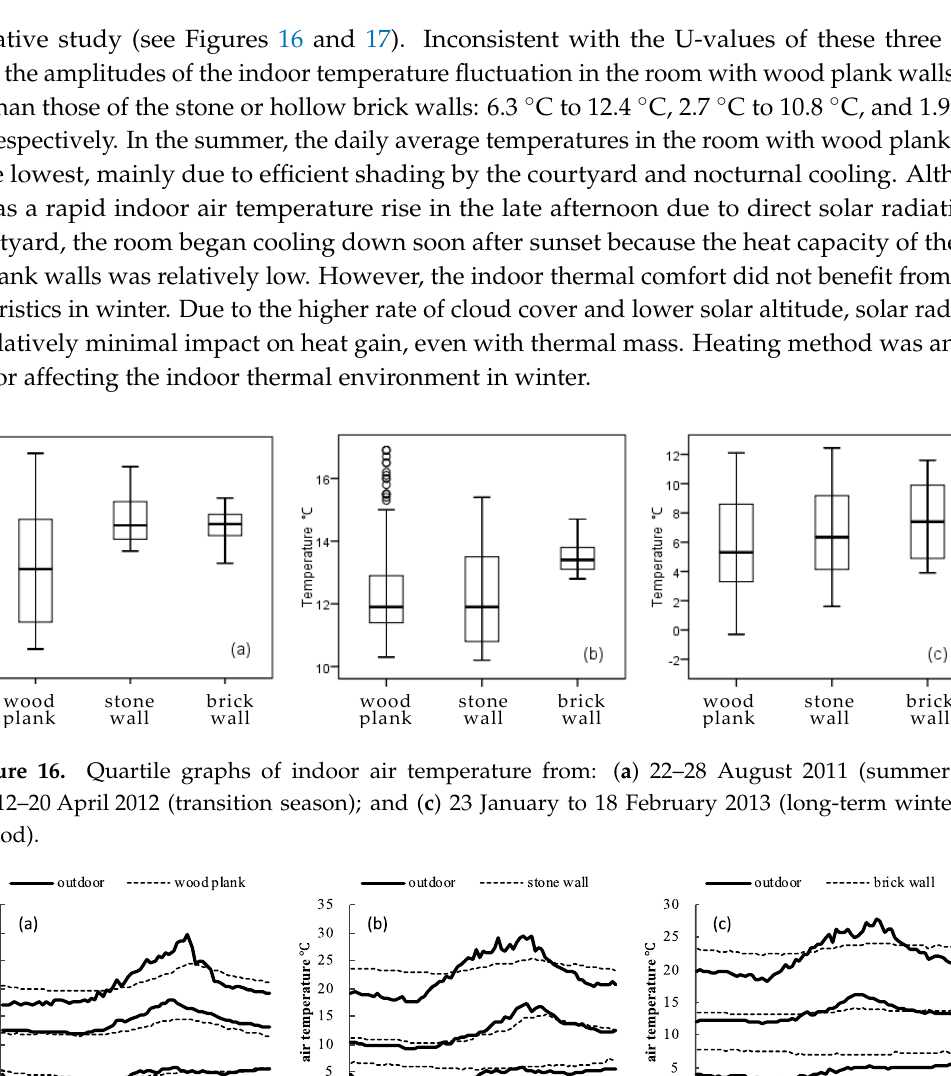
Figure 17. Air temperature distributions from: ( a ) 22–28 August 2011 (summer); ( b ) 12–20 April 2012 (transition season); and ( c ) 23 January to 18 February 2013 (long-term winter period).